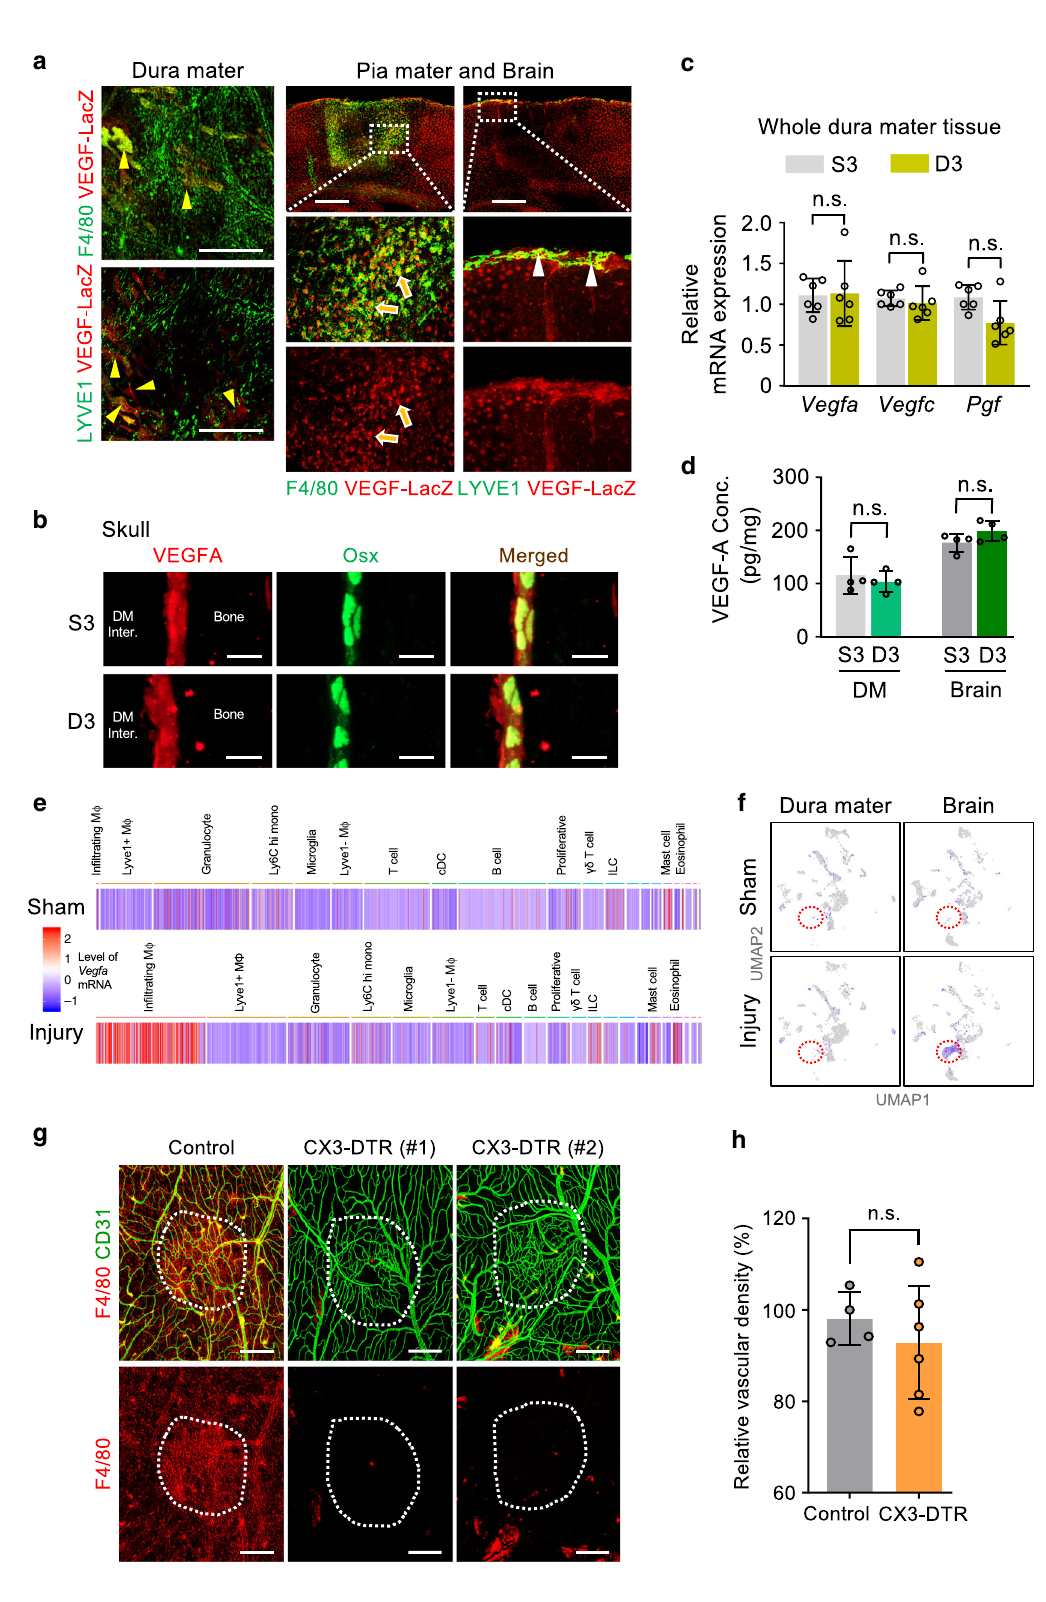
ex vivo sprouting assay 35 was performed using FACS-sorted dura mater or brain ECs. Although robust sprouting and fi lopodia were observed in dural EC spheroids, almost no sprouting and fi lopodia were detected in brain EC spheroids (Fig. 7a – c), con- fi rming that dura mater ECs have a more vigorous intrinsic angiogenic potential than brain